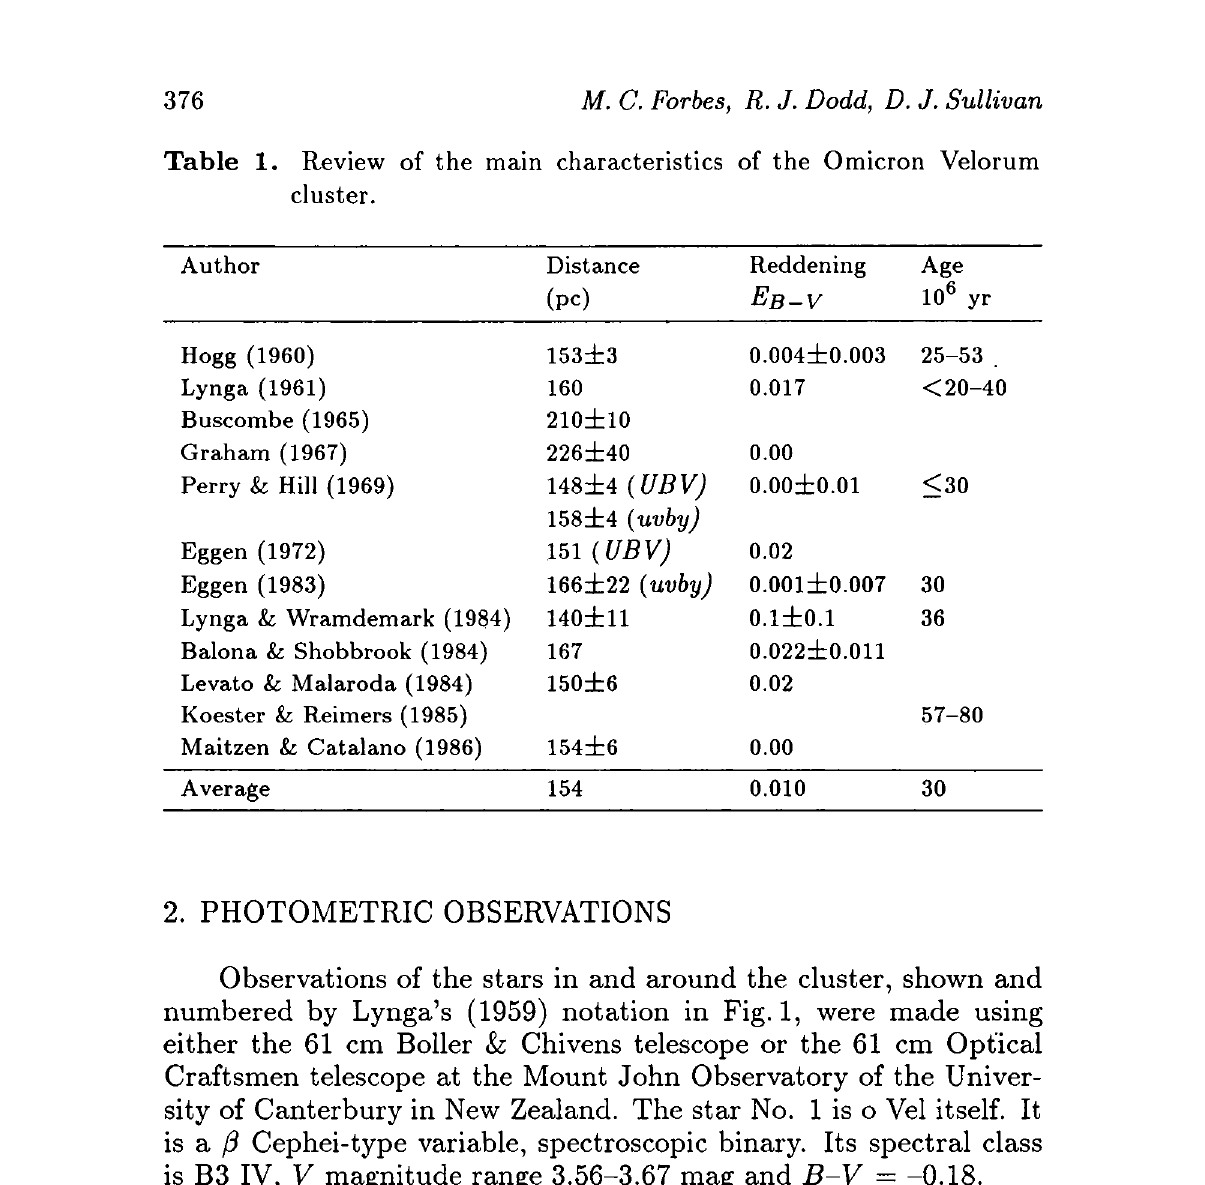
Review of the main characteristics of the Omicron Velorum